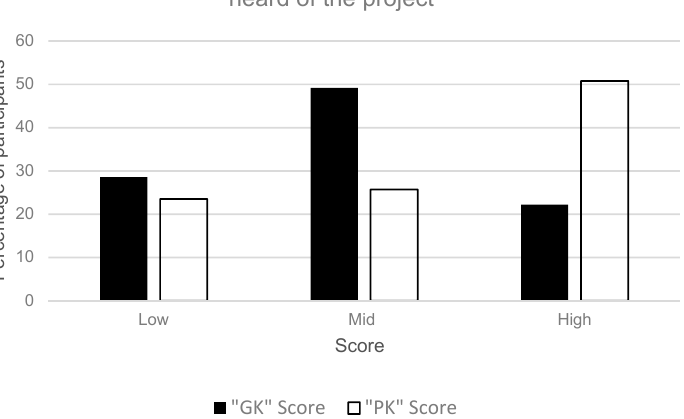
Figure 3. Distribution of general knowledge (GK) and perceived knowledge (PK) scores among the participants who have heard of the project.